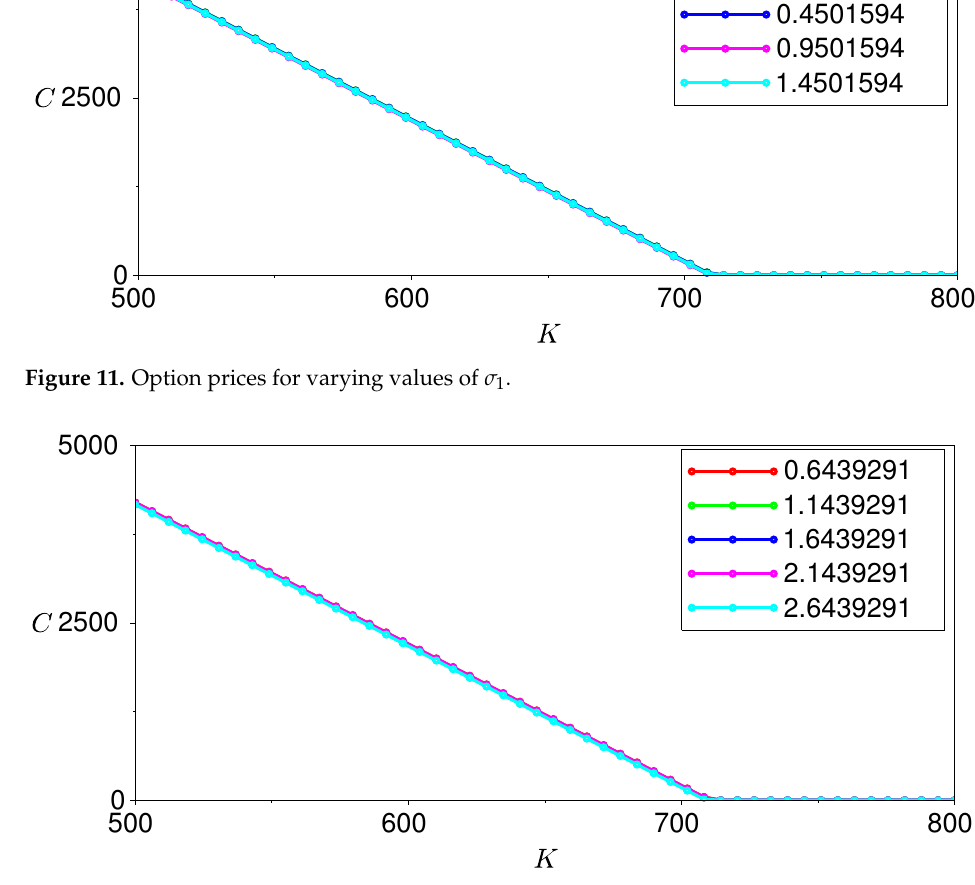
Figure 12. Option prices for varying values of σ 2